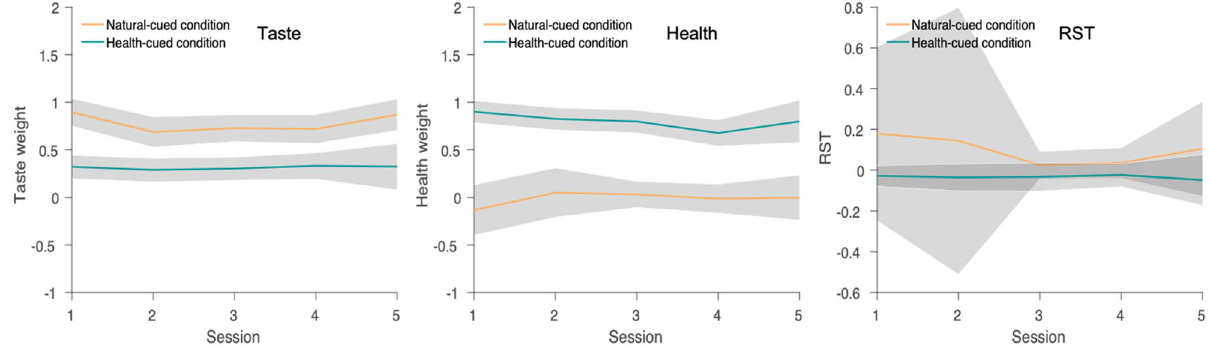
Figure 3. Group-level rstDDM parameters by condition across sessions. These three plots show the overall trends for the taste weight, health weight, and RST parameters in the natural-cued and health-cued conditions across sessions. The values for the health and taste weights are given in arbitrary units, while the RST parameter is specified in seconds. The taste weight was higher in the natural-cued condition compared to the health-cued condition in all sessions (left panel). The health weight was higher in the health-cued condition compared to the natural-cued condition in all sessions (middle panel). The RST parameter was qualitatively lower (i.e. healthiness was considered earlier) in the health-cued condition compared to the natural-cued condition in all sessions (right panel), although there was substantial individual variability in the RST parameter during the natural-cued trials. All group-level parameters other than the RST parameter for natural-cued trials were quite stable and did not differ with repeated experience across sessions. The shaded bars indicate the 95% HDIs for each parameter. The natural-cued condition is indicated by orange color and health-cued condition is indicated by green